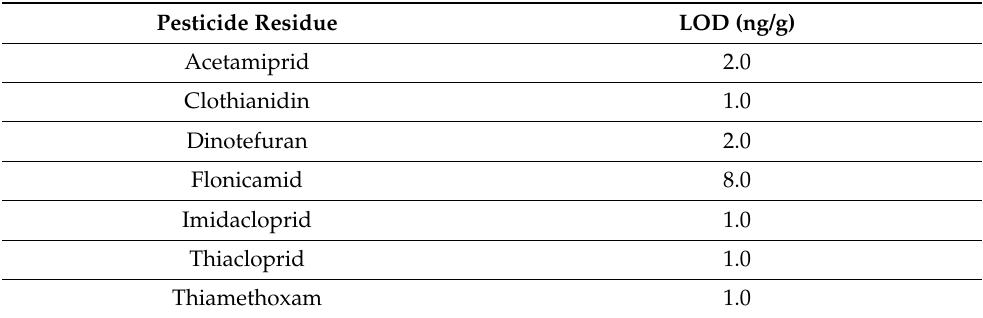
Table A1. The pesticide residues and analytical levels of detection (LOD) that were screened for during analyses.